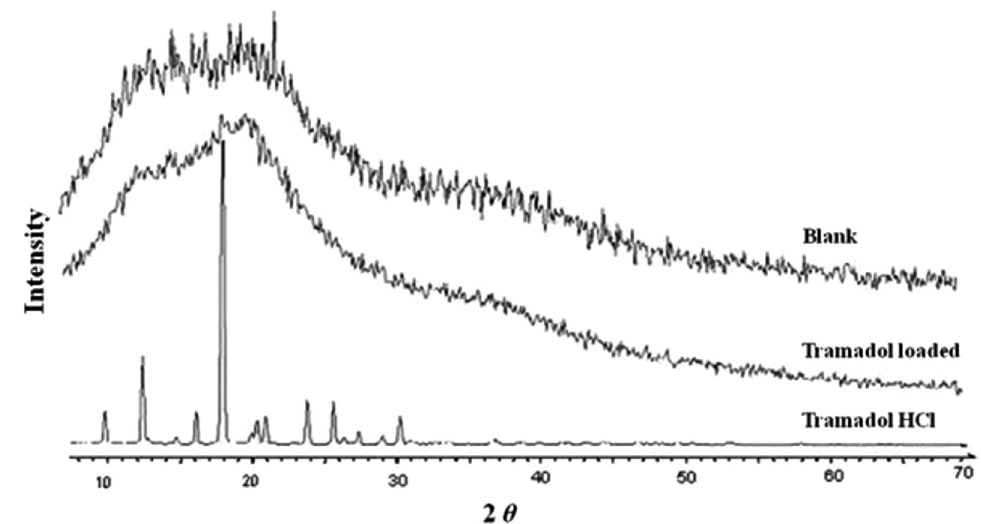
FIGURE 3 - XRD of PVP/AA hydrogel (Blank), drug-loaded PVP/AA hydrogel and tramadol HCl. TABLE IV - Amount of tramadol HCl loaded in different